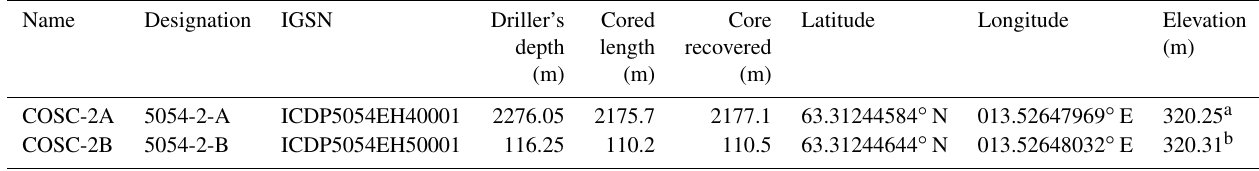
Table 1. The COSC-2 boreholes. Locations are from real-time kinematic positioning (RTK) global navigation satellite system (GNSS), the geodetic datum is WGS84 (EPSG:4326), and elevation is RH2000 (EPSG:5613). The recovered core is slightly longer than the totally cored length. Note: IGSN – International Geo Sample